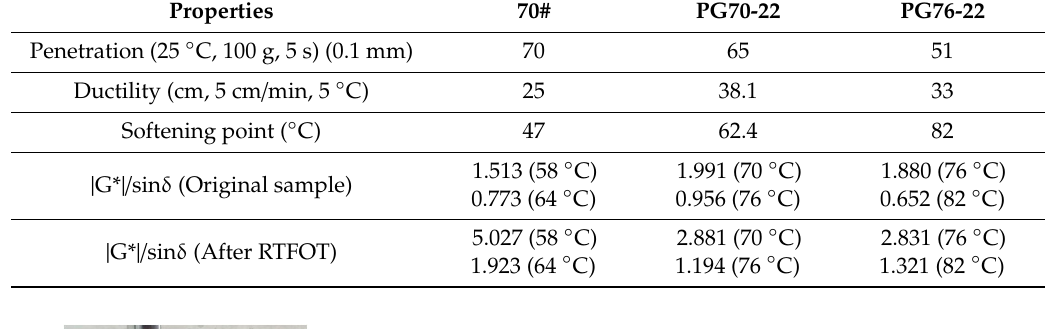
Table 1. Rheological properties of three different binders.